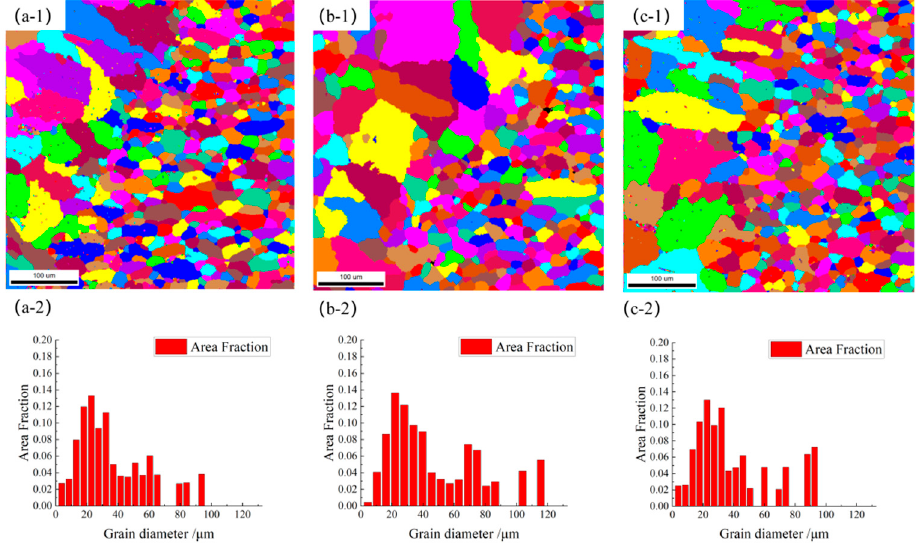
Figure 10. EBSD results near the fusion line: (( a-1 ),( a-2 )) 90 A; (( b-1 ),( b-2 )) 105 A; (( c-1 ),( c-2 )) 120 A.